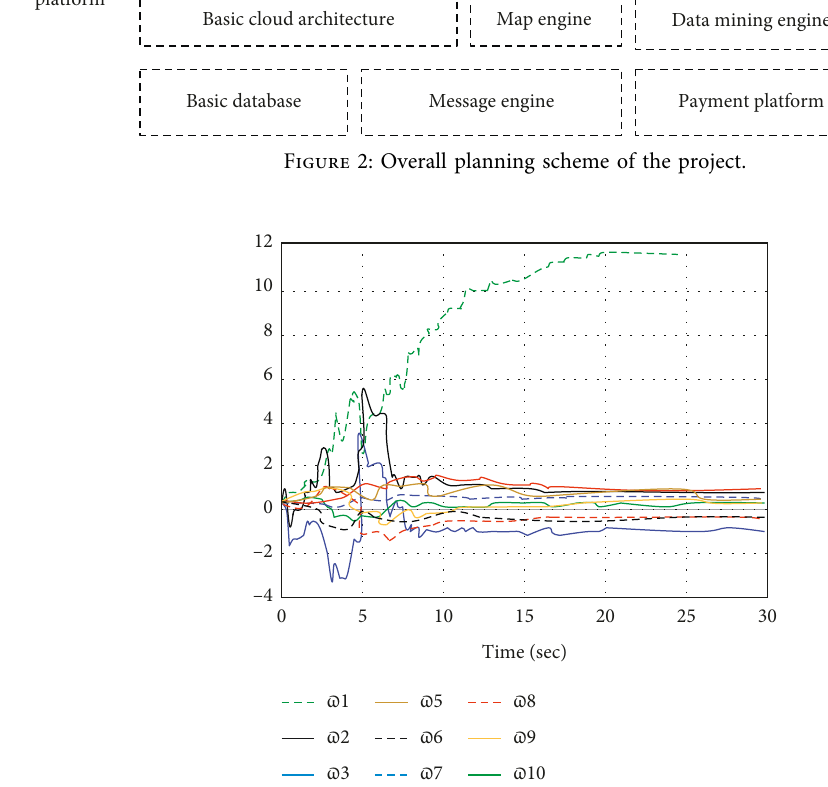
Figure 3: Convergence process of 􏽢 w